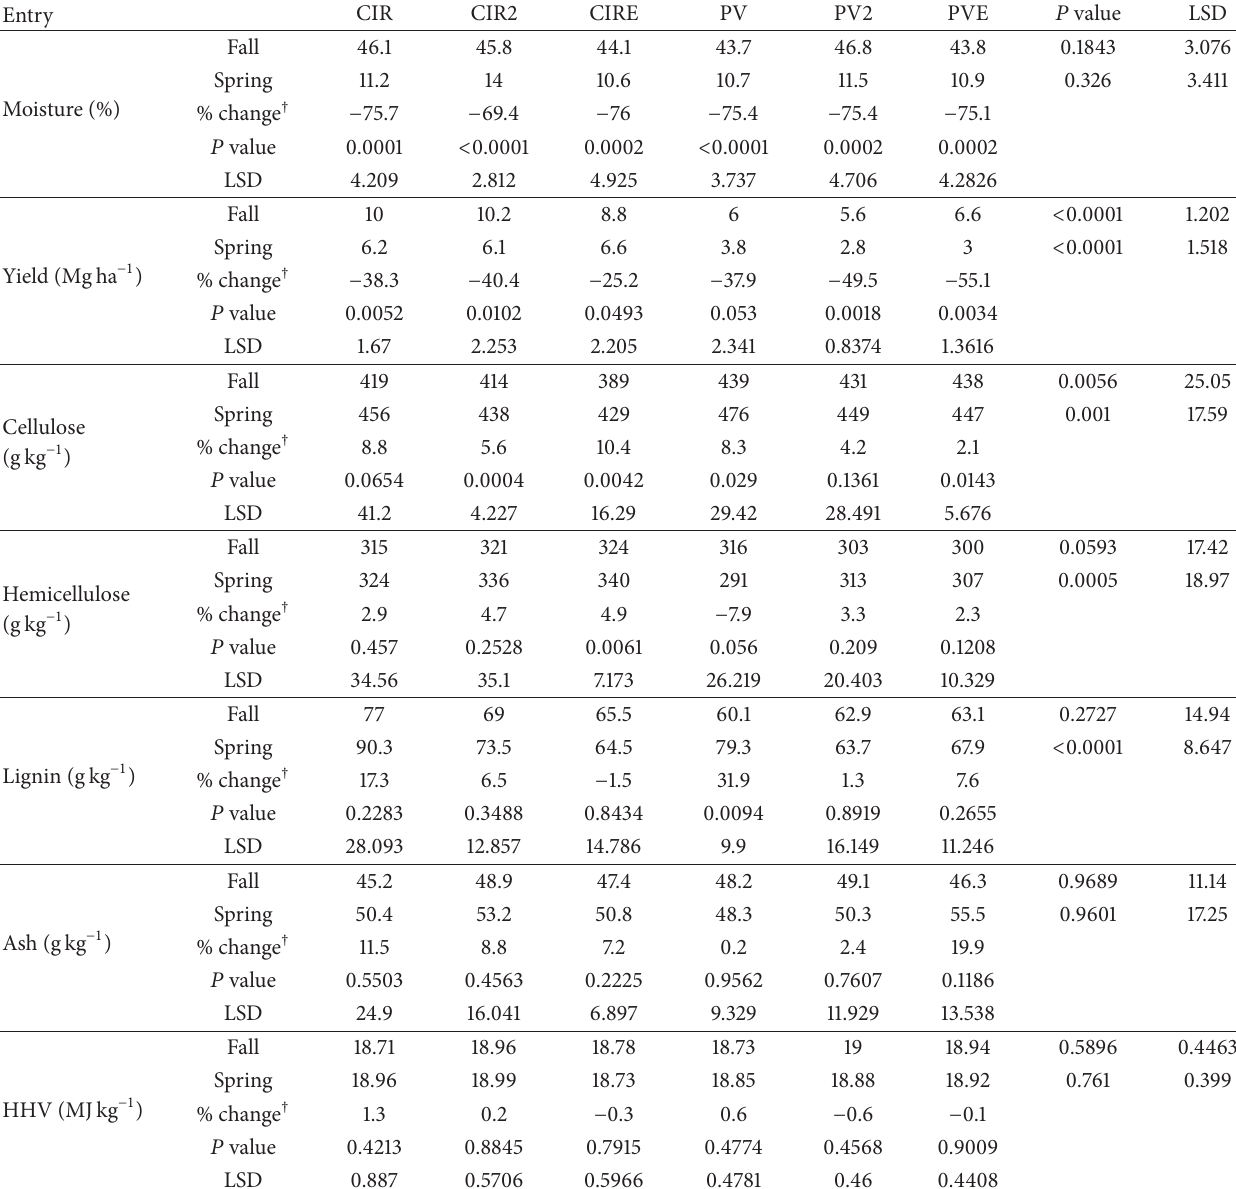
Table 4: Fall 2011 and spring 2012 values on dry matter basis for yield, moisture concentration, cell wall components, ash, and higher heating value (HHV) of three selections of switchgrass and three selections of big bluestem in Sainte-Anne-de-Bellevue,